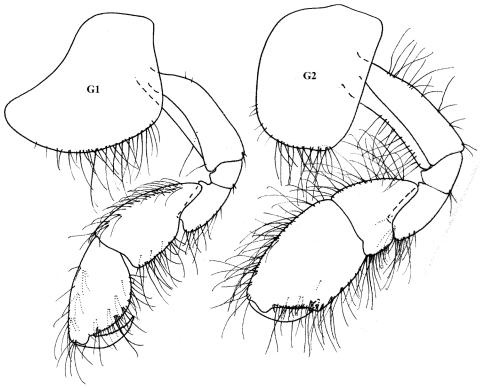

Cymadusa wistariPeart, male